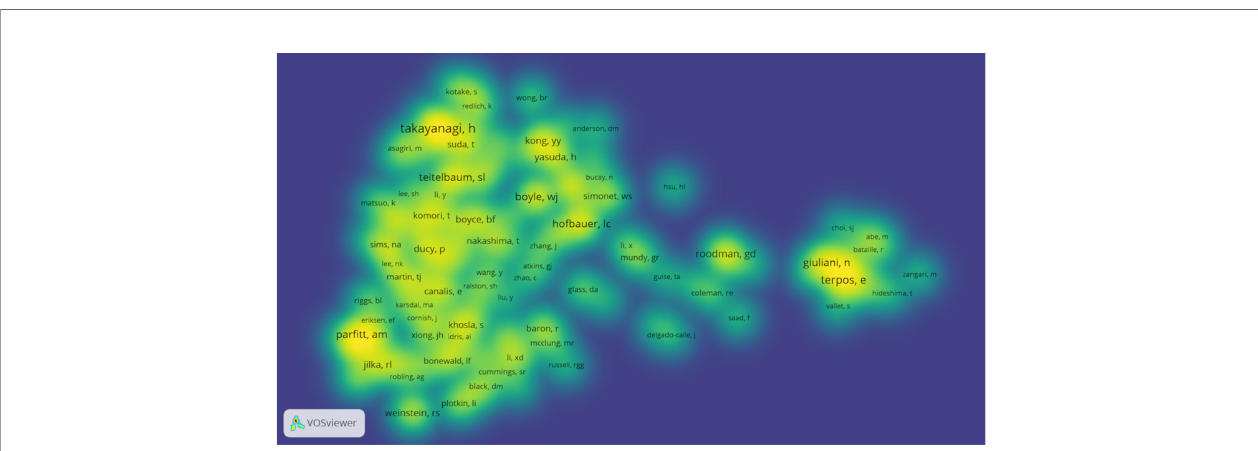
FIGURE 6 | Density map of co-cited authors in osteoblasts-osteoclasts in bone disease ( ≥ 100). Notes: The size of the word and the opacity of yellow are positively related to the co-cited